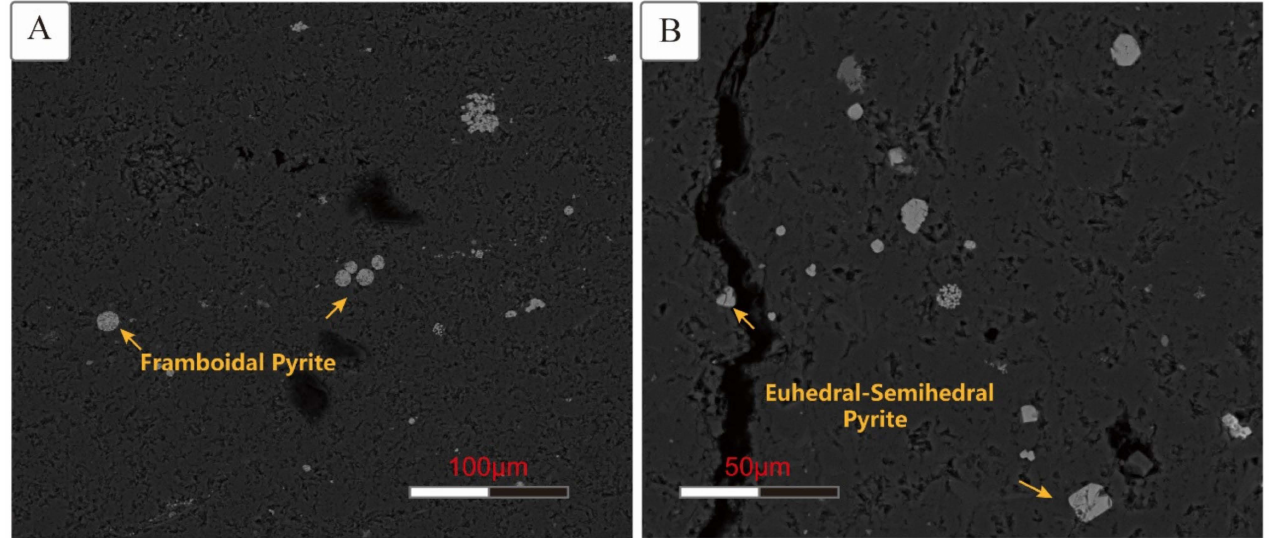
Figure 4. Microphotographs of pyrite from the Dengying Formation. ( A ) Disseminated pyrite. ( B ) Euhedral pyrite and semihedral